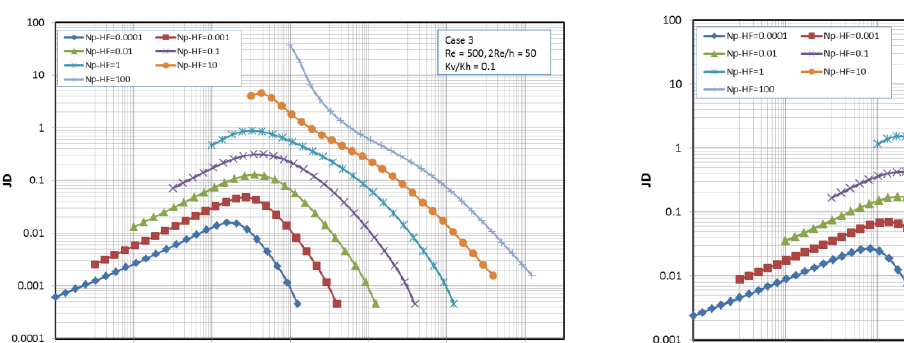
/h = 10 and k /k = 0.1. Figure 8—Case 2with x e /h = 20 and k v /k h = 0.1. e v h